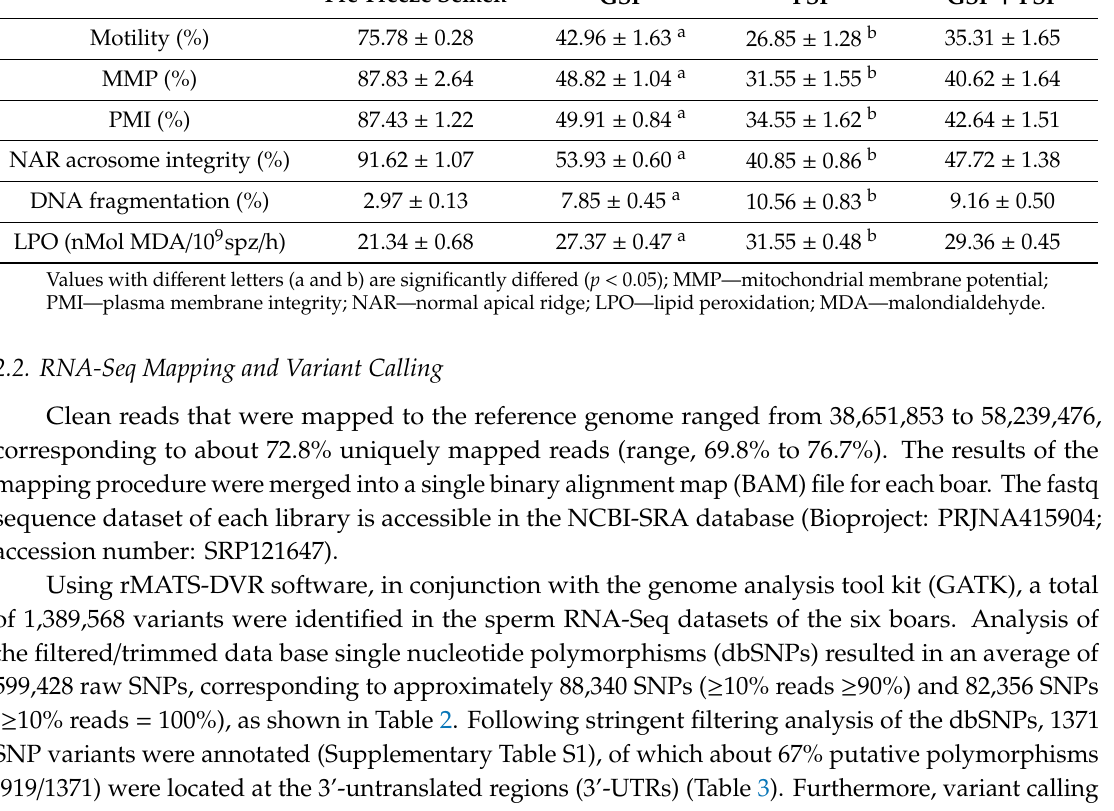
Table 1. Fresh, pre-freeze, and post-thaw quality of boar semen. Data are presented as the mean ± SEM of 21 and 19 boars with good and poor semen freezability (GSF and PSF, respectively). Post-Thaw Semen Total Fresh, Sperm Parameters Pre-Freeze Semen GSF PSF GSF + PSF Motility (%) 75.78 ± 0.28